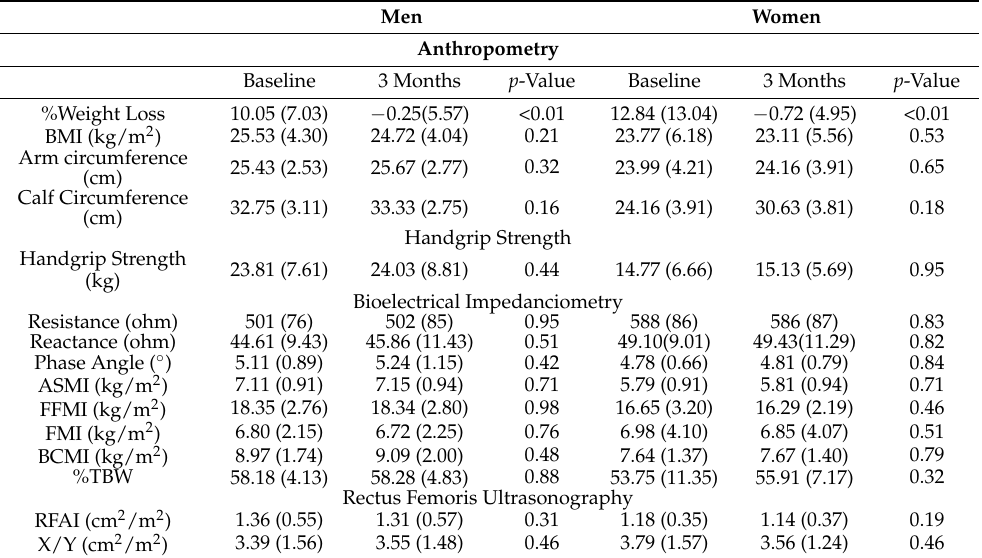
Table 6. Changes in anthropometry, body composition and muscle function according to gender at baseline and 3 months after nutritional intervention.